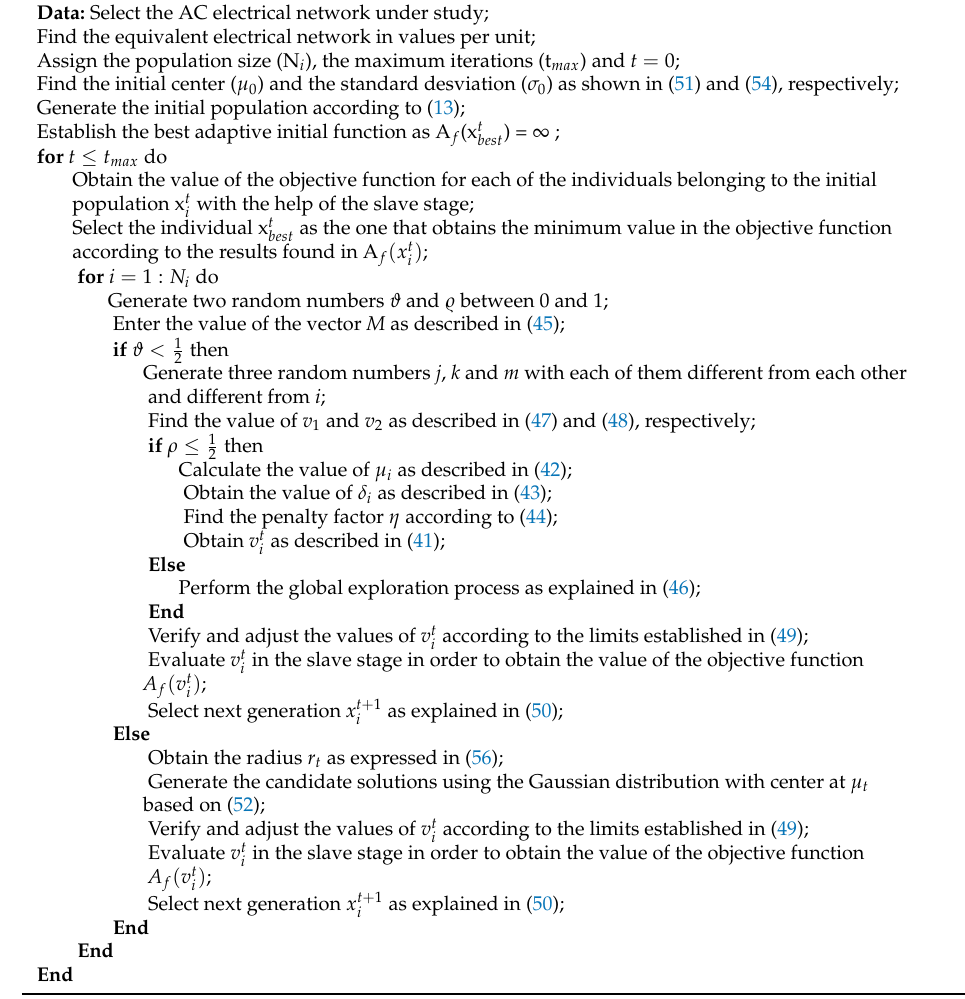
Algorithm 1. Improved implementation of the GNDO based on the VSA.